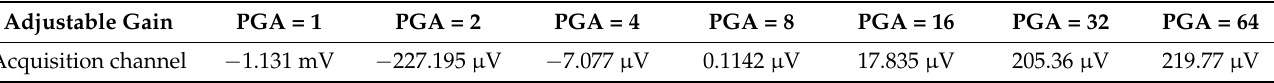
Table 1. Short-circuit at the input end of the measurement data (250SPS).